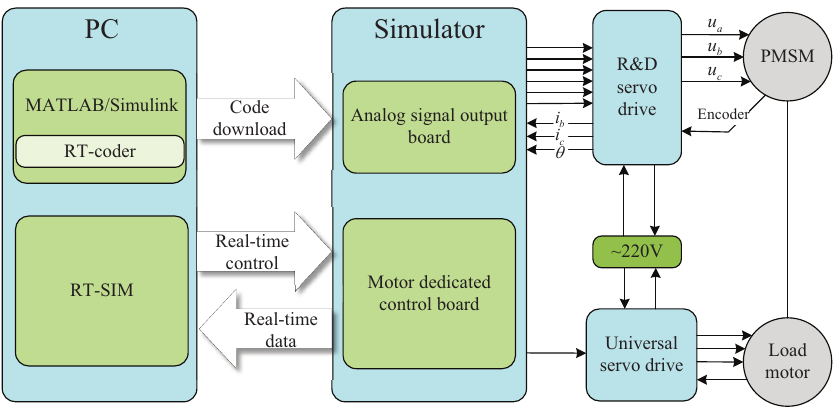
Figure 12. Experimental configuration of PMSM